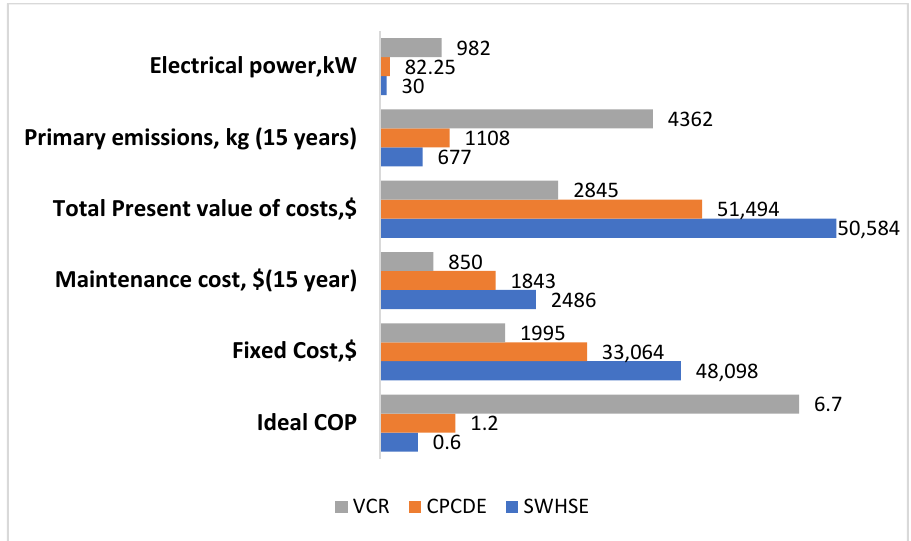
Figure 10. Comparison of performance of the best ranking single effect solar method (SWHSE), double effect solar method (CPCDE) and vapor compression method(VCR) for Riyadh (BWh).